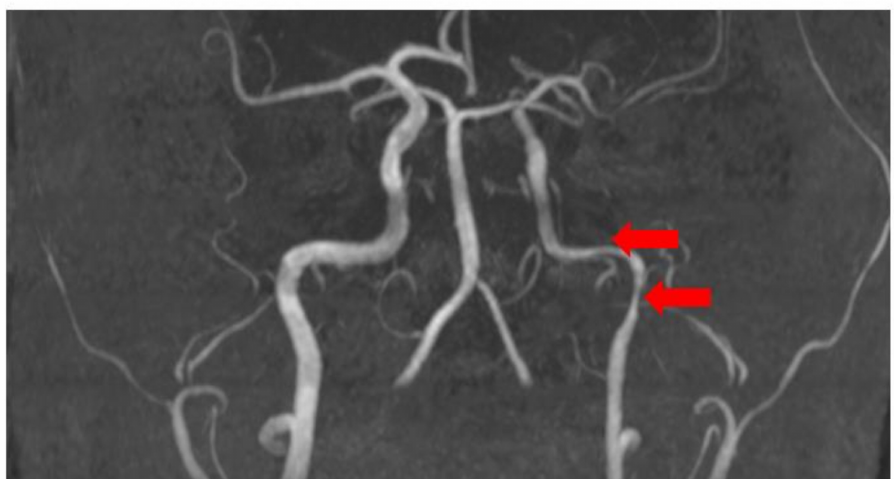
Figure 3. Segmentary stenosis in the extracranial part of the left internal carotid artery (MRA) (red